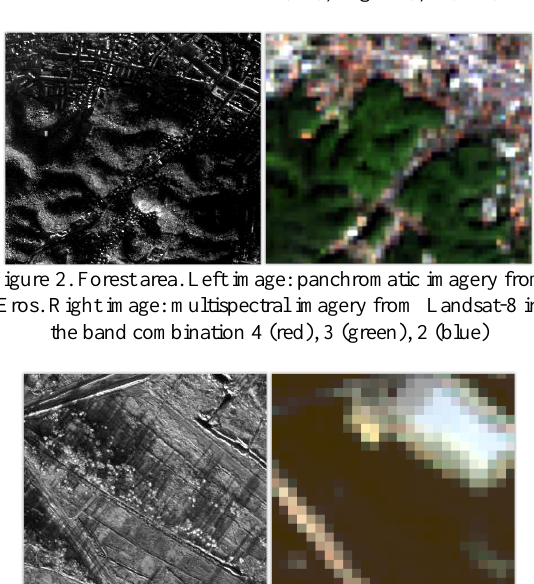
Figure 1. High urban area. Left image: panchromatic imagery from Eros. Right image: multispectral imagery from Landsat-8 in the band combination 4 (red), 3 (green), 2 (blue)